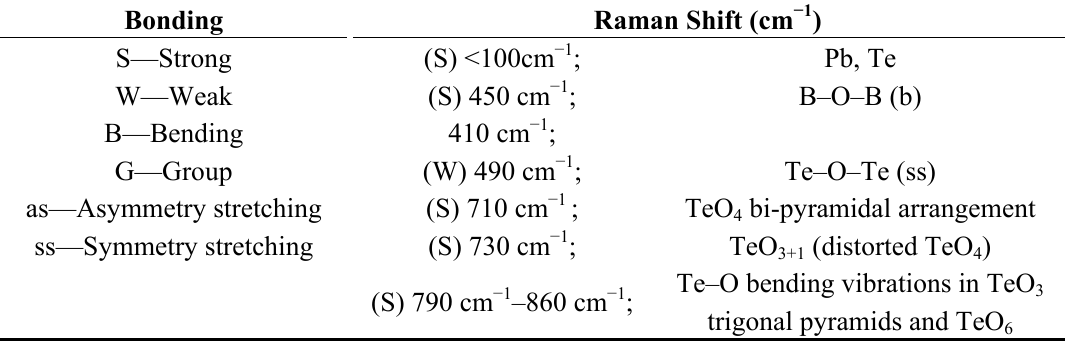
Table 1. Marker labeling Raman peak according to chemical bonding and stretching [12].